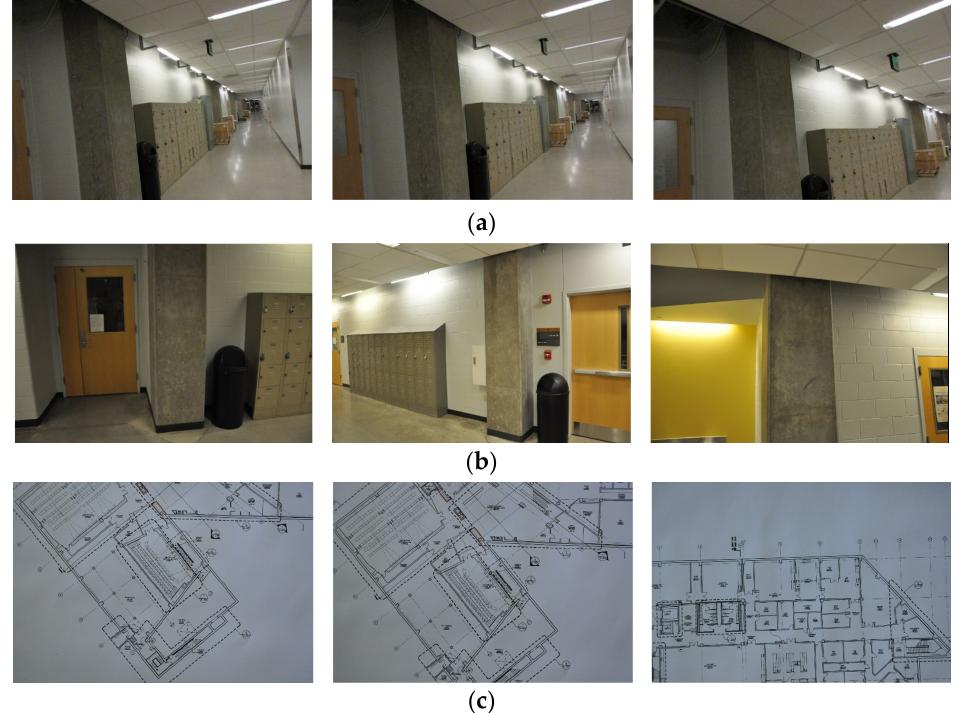
Figure 5. Sample images collected during the test: ( a ) PathImgs, ( b ) InspImgs, and ( c )